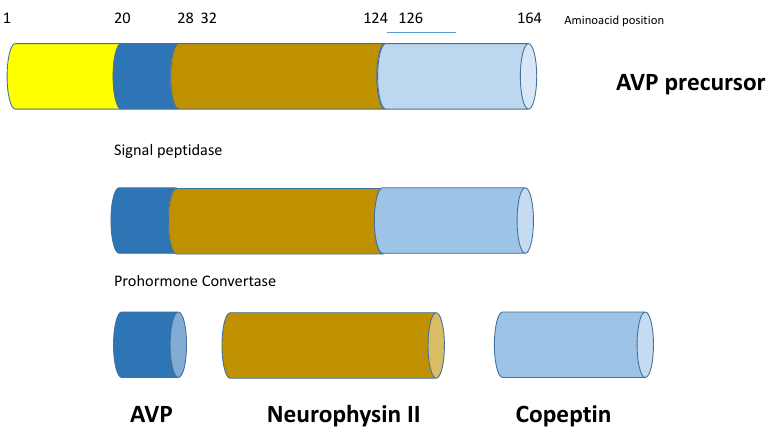
Figure 1. Schematic structure of prepro-vasopressin-neurophysin II-copeptin. Copeptin is the 39-amino acid glycopeptide constituting the C-terminal portion of arginine-vasopressin (AVP) precursor (pro-AVP); it is produced and released into the bloodstream stoichiometrically with AVP. Pro-AVP is synthesized in paraventricular and supraoptic magnocellular neuronal nuclei of the hypothalamus. Enzymatic cleavage during axonal transport towards the pituitary gland ensures the formation of the two mature molecules, as well as their split from their carrier, neurophysin II.